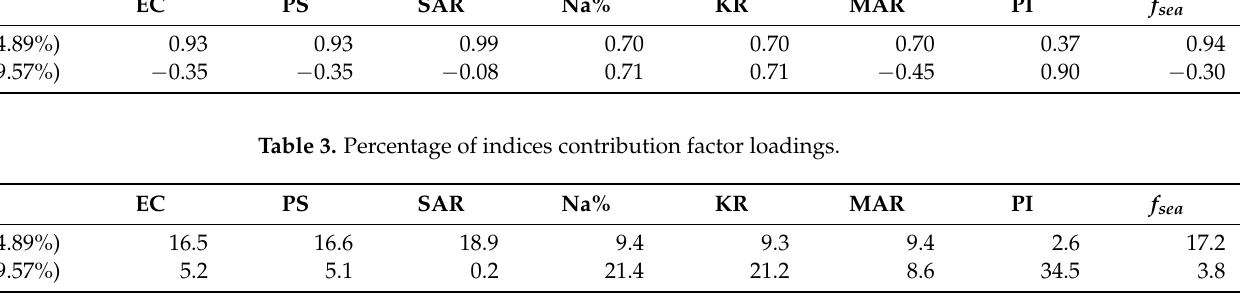
Figure 11. Correlation map of f sea , EC, PS, SAR, Na%, KR, MAR, and PI, with the significance mark ( p -value <= 0.05 represented by *).